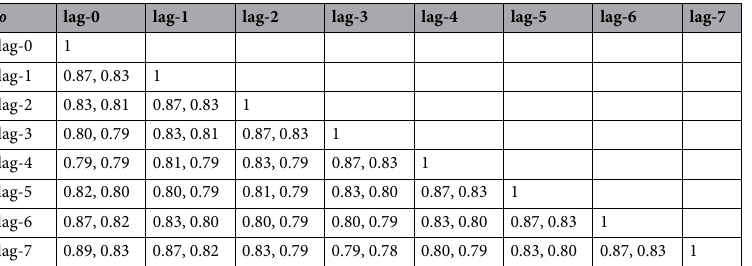
Table 1. Pearson and Spearman-rank correlation coefficients from the incidence data, rounded to two digits after